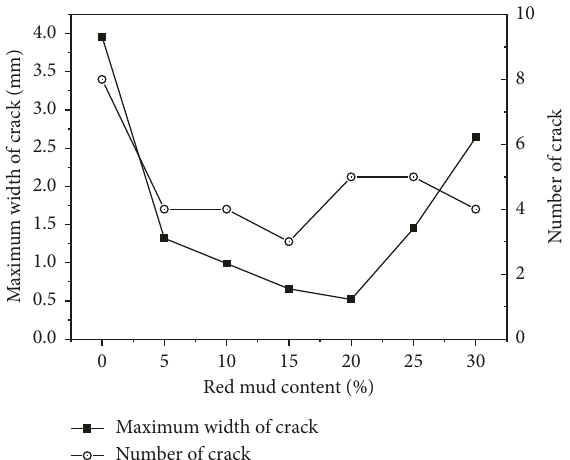
Figure 10: Crack number and maximum crack width as a function of RMC added to concrete cured for 28 days.